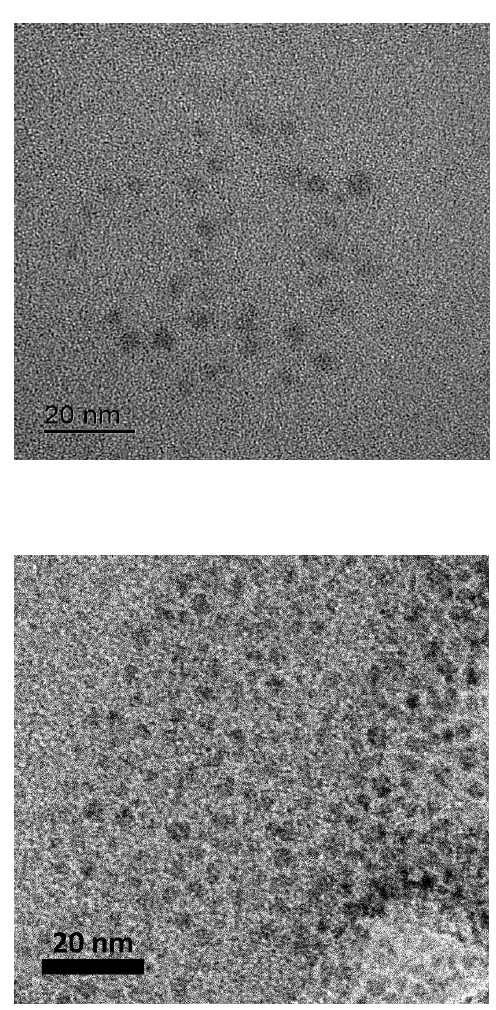
Figure 1. ( b ) TEM picture for carbon dots at ~5 nm.